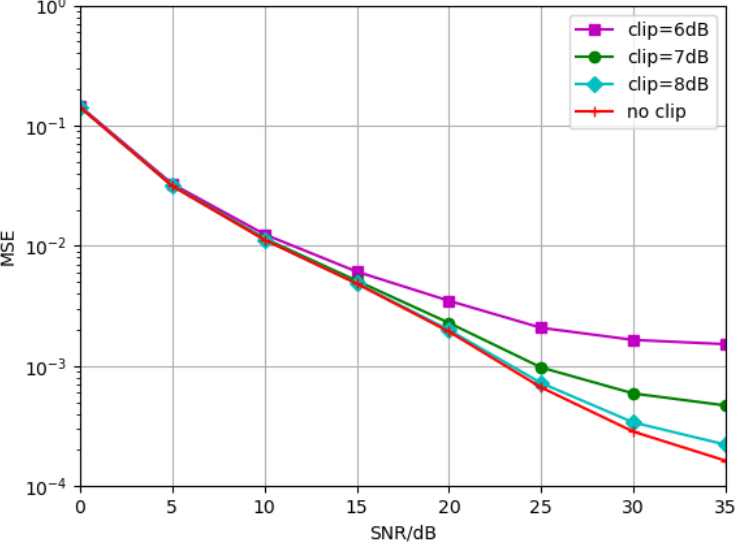
Figure 16. Generalization performance of NDR-Net trained without signal clipping, tested under the conditions of signal without clipping, signal clipped to 6 dB, 7 dB and 8 dB,